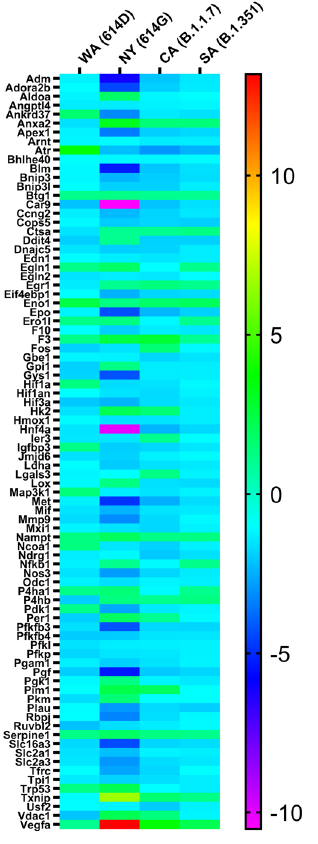
Fig. 7 Heatmap of transcriptional genes of the hypoxia pathway following SARS-CoV-2 infections. K18-hACE2 mice of both sexes (~1:1 ratio) were infected intranasally with USA-WA1/2020 (WA) of lineage A bearing 614D (10 4 TCID 50 /mouse), New York-PV09158/2020 (NY) of lineage B.1.3 bearing 614G (10 3 TCID 50 /mouse), USA/CA_CDC_5574/2020 (CA) of lineage B.1.1.7 (10 2 TCID 50 /mouse) or hCoV-19/South Africa/KRISP-EC- K005321/2020 (SA) of lineage B.1.351 (10 2 TCID 50 /mouse). Hypoxia